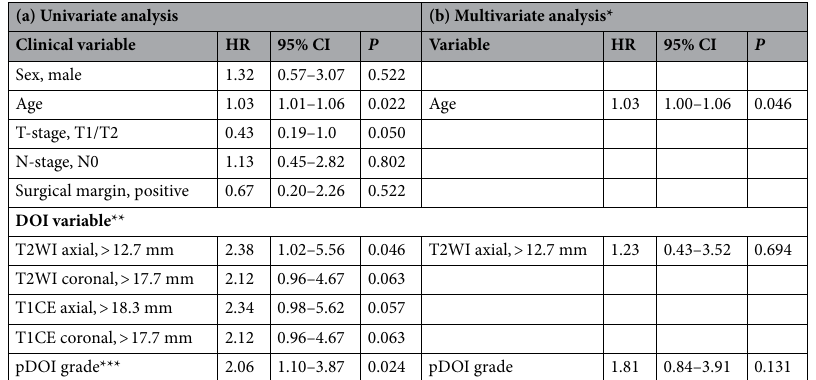
Table 3. Cox proportional hazards analysis of recurrence-free survival. HR hazards ratio, CI confidence interval, T2WI T2-weighted image, T1CE T1-weighted contrast enhanced image, pDOI pathologic depth of invasion. *Variables with P < 0.05 from univariate analysis were chosen. **Cutoff values were determined by optimal stratification based on log-rank statistics. ***Grade 1 (pDOI < 5 mm); grade 2 (pDOI 5–10 mm); grade 3 (pDOI ≥ 10